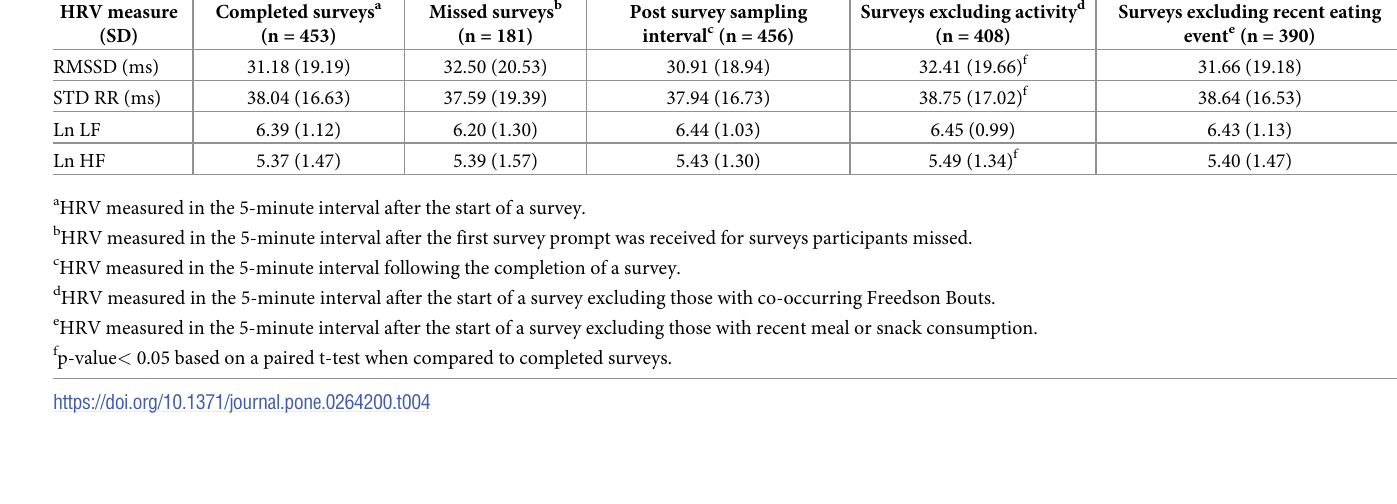
Table 4. Mean HRV by survey completion, sampling interval, physical activity, and recent eating event. HRV measure Completed surveys (SD)